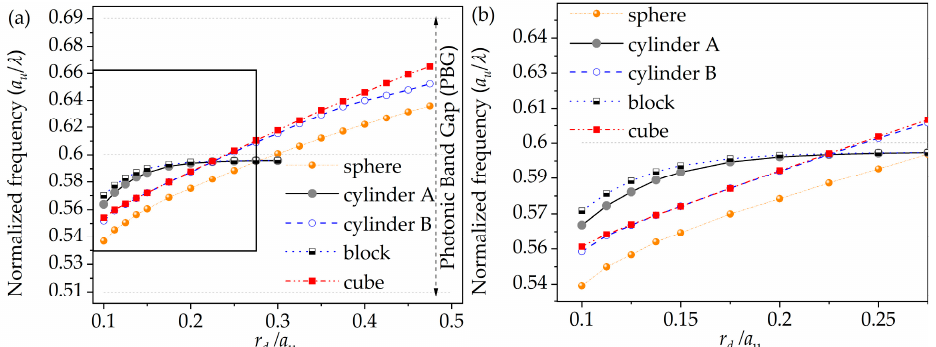
Figure 5. The normalized frequency of resonance peaks ( a u / λ ), as a function of the normalized radii ( r d / a u ). The dashed lines indicate the limits of the full bandgap from a u / λ ~0.506 to 0.694 and its mid-gap frequency a u / λ ~0.600. ( b ) Zoom-in of the highlighted region in ( a ). The corresponding Q -factors obtained for the different defect types are shown in Figure 6. They decrease with increasing defect size. Overall, the Q -factors of the various defect types behave similarly.